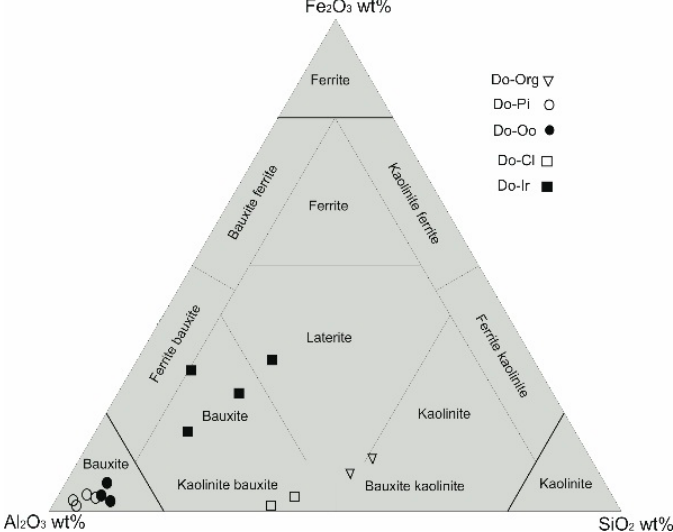
Figure 7. Ternary plot of the SiO 2 –Al 2 O 3 –Fe 2 O 3 –system (after [52]) showing the Dopolan deposit data.